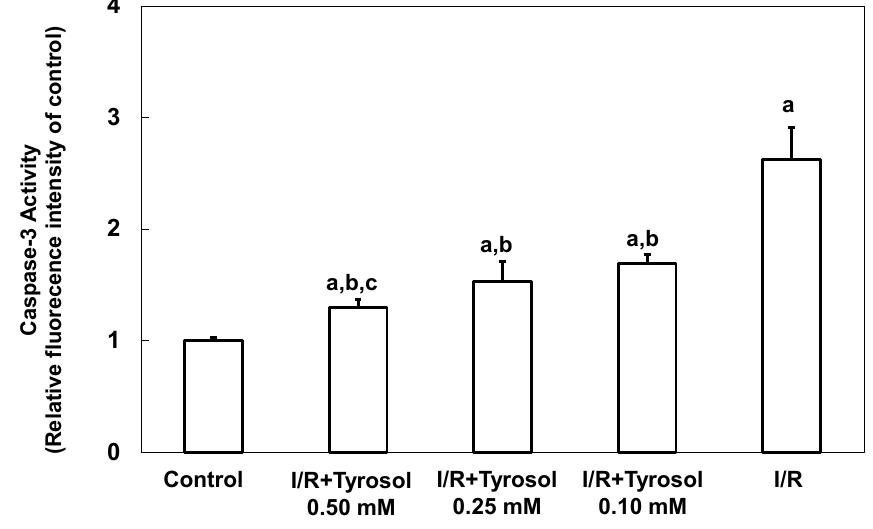
Figure 3. Effect of tyrosol on caspase-3 activity in H9c2 cardiomyocytes during I/R. Cells were pretreated with tyrosol at 0.10, 0.25, or 0.50 mM for 24 h, then subjected to I/R in